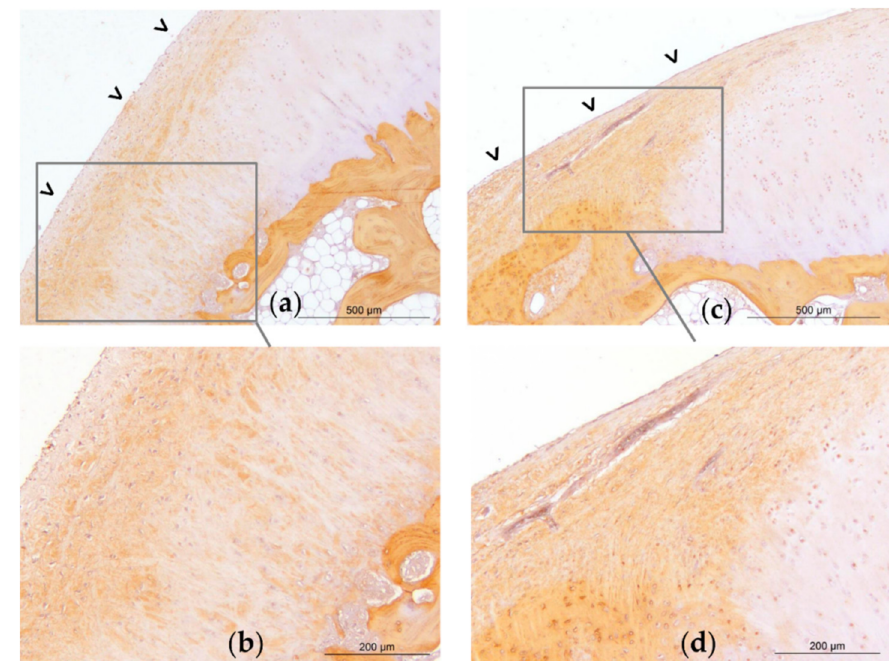
Figure 9. Representative light micrographs of osteochondral sections of the medial part of the distal aspect of the metacarpal condyles of horse 1. Micrographs obtained on Week 12, revealing type I collagen labelling (brown marking), and illustrating a grade 18 histological score on the left metacarpal condyle treated with umbilical cord blood derived mesenchymal stem cells (UCB-MSCs) ( a – b ) and on the right metacarpal condyle treated with placebo ( c – d ). On the UCB-MSC treated joint, there is mild erosion of the superficial layer of the articular cartilage ( a ). On both joints, there is a large fibrocellular tissue (open arrow heads) that is partly positive for type I collagen, and under which the tidemark is no longer present. The chondrocytes of the deep layers are also marked with type I collagen. The subchondral bone appears